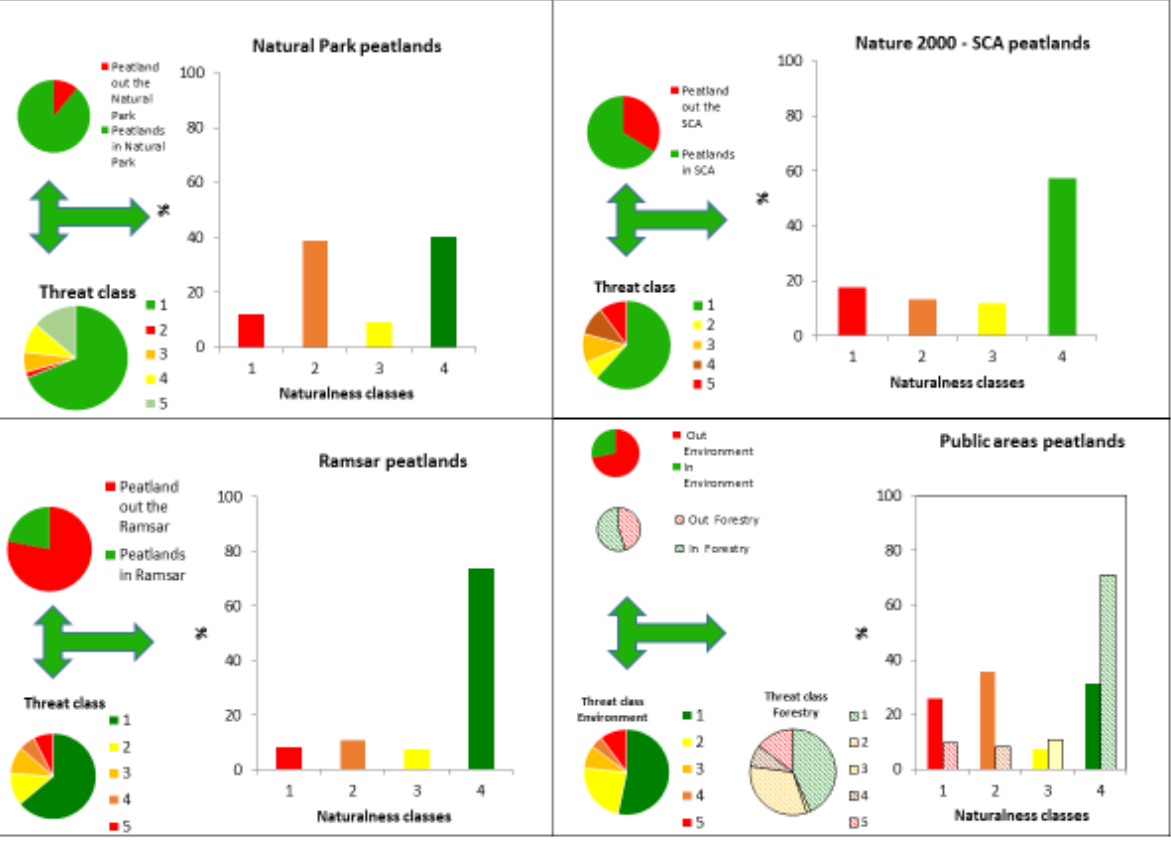
Figure 6. Proportion of peatland within and outwith each type of area considered (Natural Park, SCA, Ramsar, public areas). Peatland naturalness and threat classes are identified in each case. Classes of naturalness: 1 = disturbed; 2 = altered; 3 = conserved; 4 = wild. Classes of threat: 1 = no risk; 2 = minimal risk; 3 = potential risk; 4 = actual risk; 5 = immediate